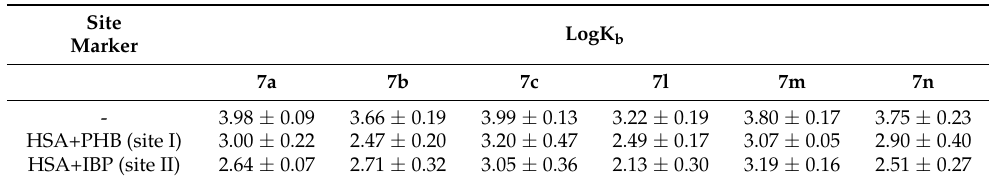
presence of site markers phenylbutazone (PHB) and ibuprofen (IBP) at 297 K. Site